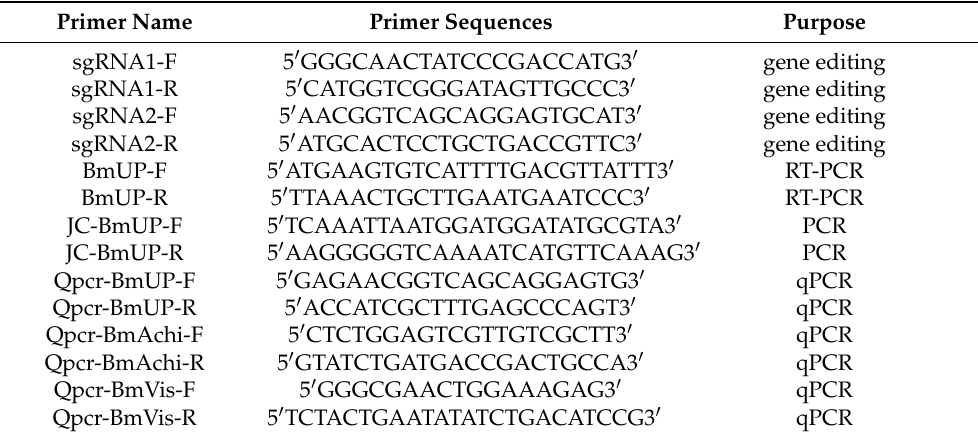
Table 1. List of primer sequences used in this